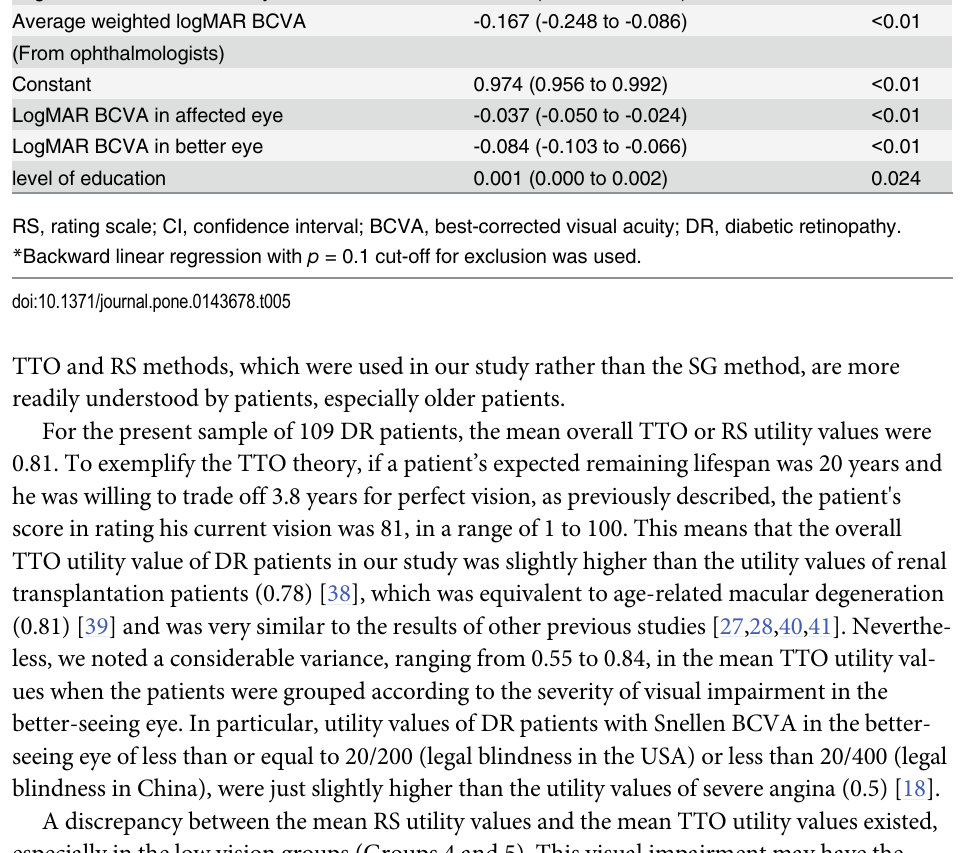
Table 5. Predictors of rating scale utility values from diabetic retinopathy patients and ophthalmolo- gists, determined by multiple linear regression.